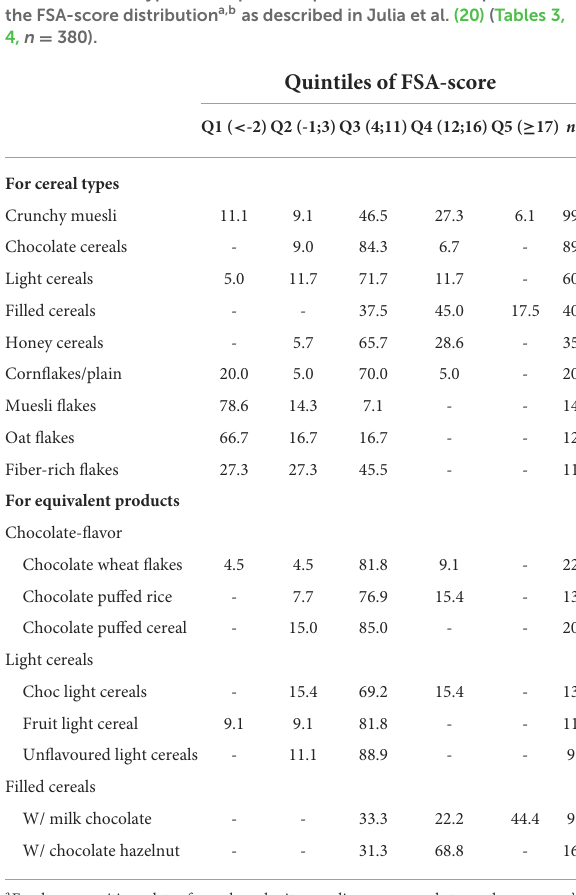
TABLE 3 Discriminating performance of Nutri-Score: distribution of breakfast cereal types and equivalent products (%) across quintiles of the FSA-score distribution a,b as described in Julia et al. (20) (Tables 3, 4, n = 380). Quintiles of